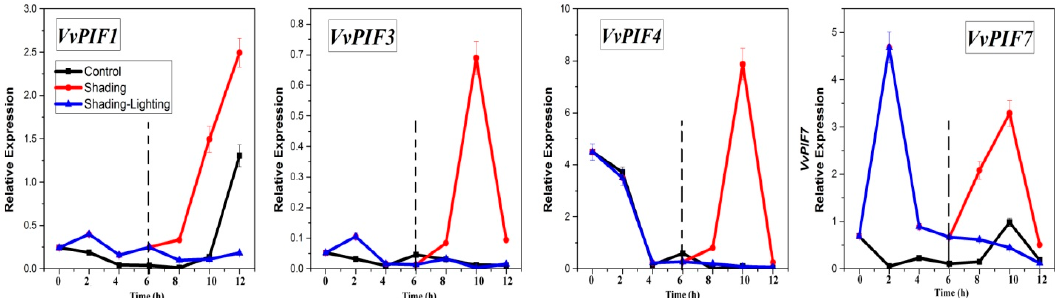
Figure 8. Relative expression levels of VvPIFs in the leaves of SB under light/shading conditions. The expression levels were calculated based on the 2 − ∆ Ct method.